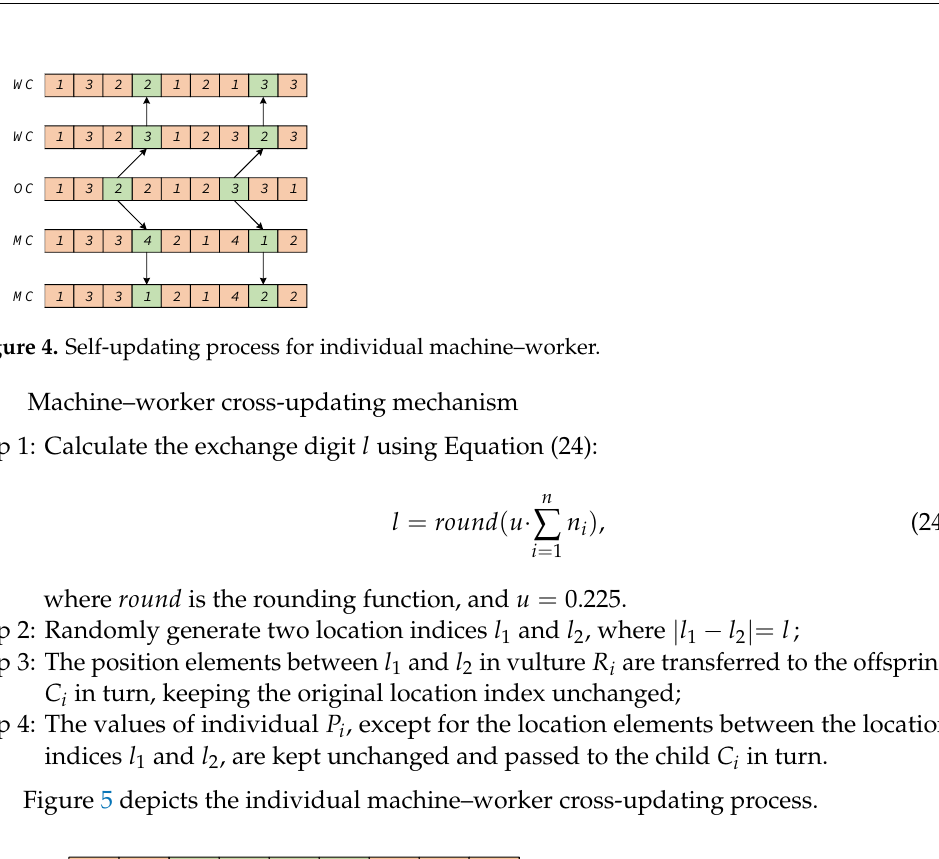
θ Figure 3. Operation update mechanism of the individual. 2.